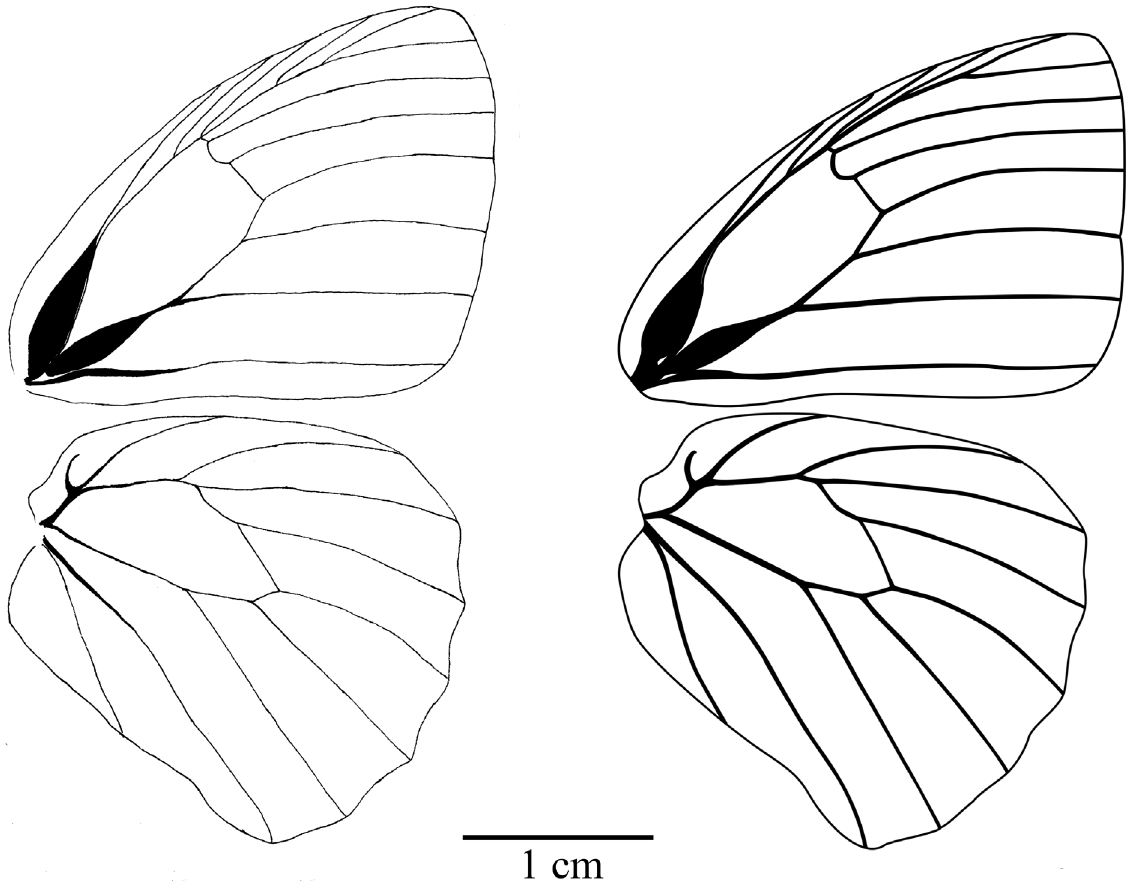
Fig. 11. Zischkaia pacarus (Godart, 1824), wing venation. A . ♂ (FLMHN-MGCL-1036002). B . ♀ (MGCL-LOAN